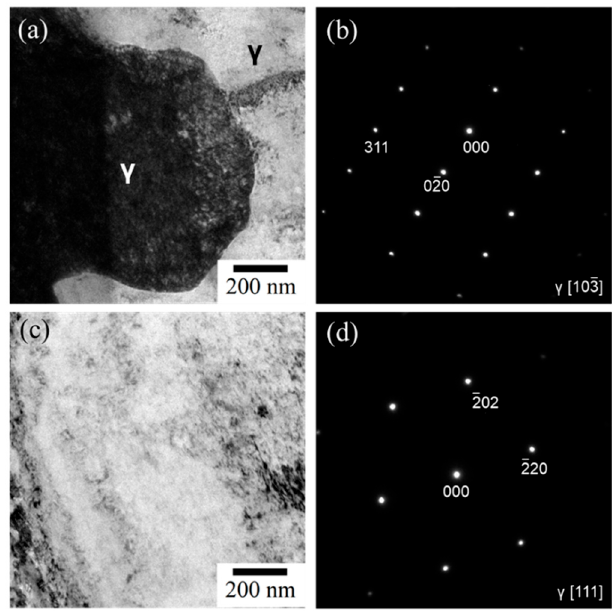
Figure 10. Transmission electron microscopy (TEM) images of specimens pre erosion: ( a ) A, ( b ) SAED (selected area electron diffraction) pattern of A, ( c ) HSA, and ( d ) SAED pattern of HSA.